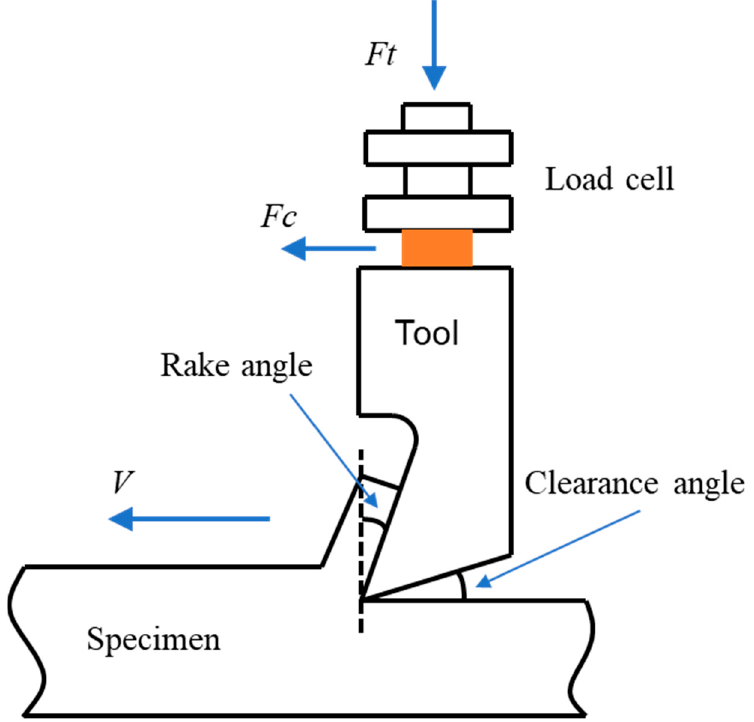
Figure 1. Schematic diagram of the orthogonal cutting rig setup.